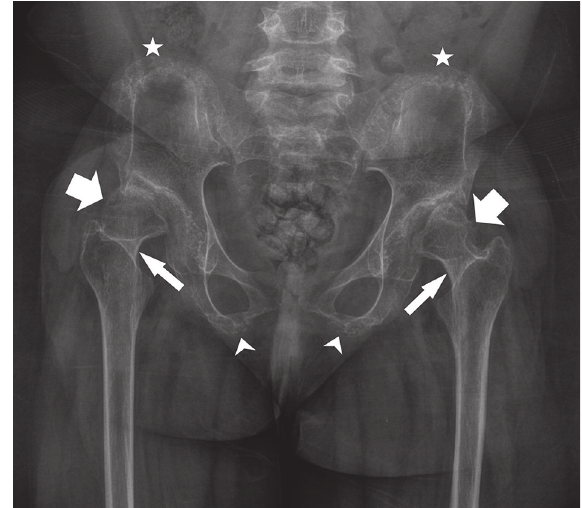
Figure 3: Pelvic and hip abnormalities associated with DMC syndrome. The pelvis with both hips is depicted. Both femoral heads are essentially dislocated/severely subluxated from the shallow, dysplastic acetabulum with resultant formation of a pseudoacetabulum superior and lateral to the native acetabulum bilaterally (thick arrow). Both femoral heads are deformed and small in size (thick arrow). There is premature growth plate fusion at the proximal femoral epiphyses (thin arrow). The iliac rest margins appear deformed (star). The ischial bones and inferior pubic rami are hypoplastic as well (arrowhead). There is decreased bone mineral density throughout, and the bones appear